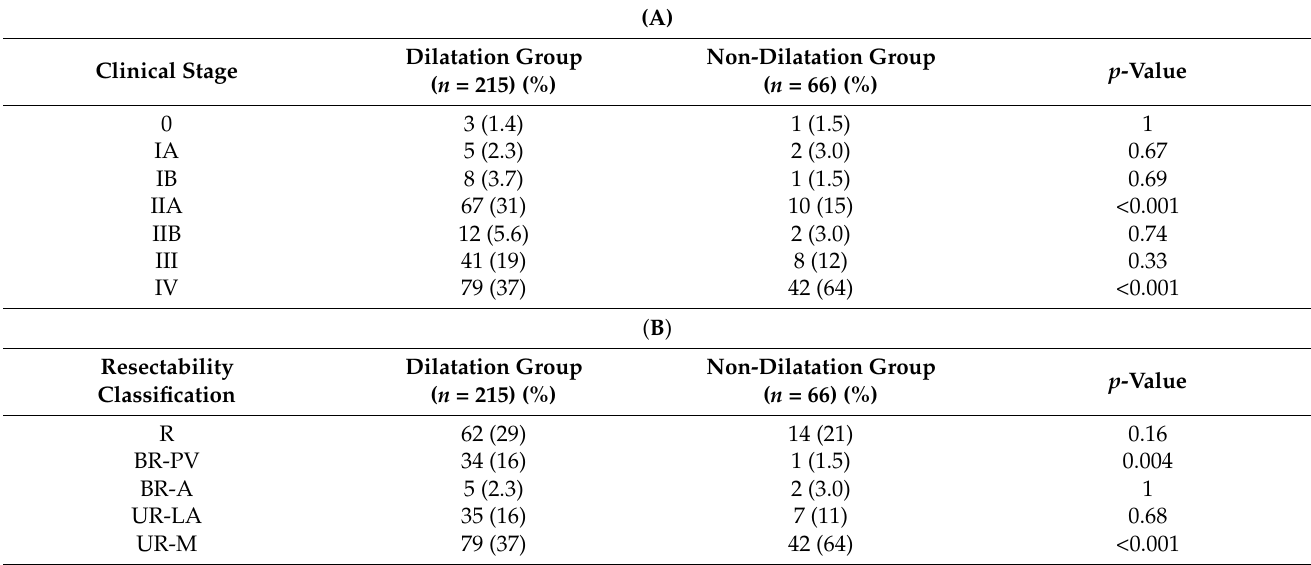
Table 5. ( A ) Clinical stage. ( B ) Resectability classification.